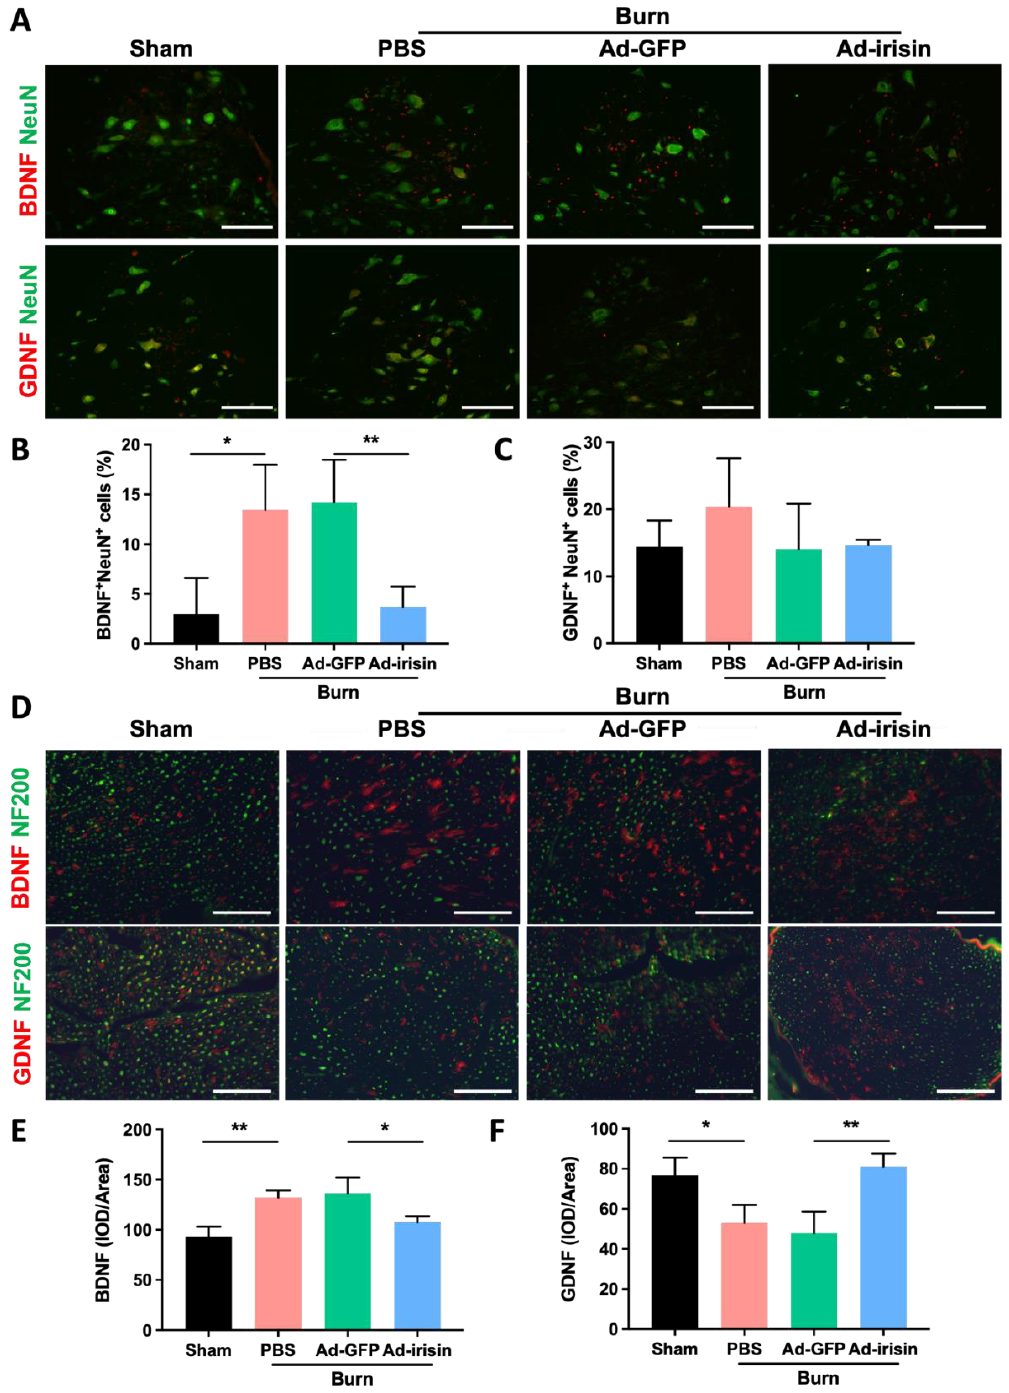
Figure 5. Spinal irisin gene delivery modulated BDNF and GDNF expression in the ventral horn and sciatic nerve after burn injury. ( A ) Immunofluorescence staining of BDNF and GDNF in the ventral horn in the fourth week after burn injury. NeuN staining was used to visualize neuron cells. ( B , C ) Representative bar graphs illustrating the ratios of BDNF+NeuN+ and GDNF+NeuN+ cells. Error bars represent standard deviations (SDs). * p < 0.05, ** p < 0.01, unpaired t-test. ( D ) Immunofluorescence staining of BDNF and GDNF in the sciatic nerve in the fourth week after burn injury. NF200 staining was used to visualize neurofilaments. ( E , F ) Representative bar graphs illustrating averaged optical intensity of BDNF and GDNF. Error bars represent SDs. * p < 0.05, ** p < 0.01, unpaired t-test.